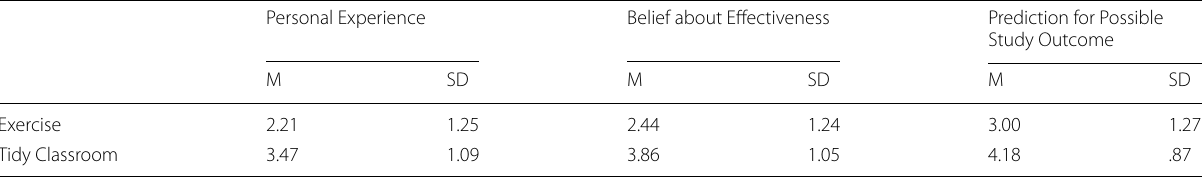
Table 2 Descriptive statistics for baseline beliefs about interventions Personal Experience Belief about